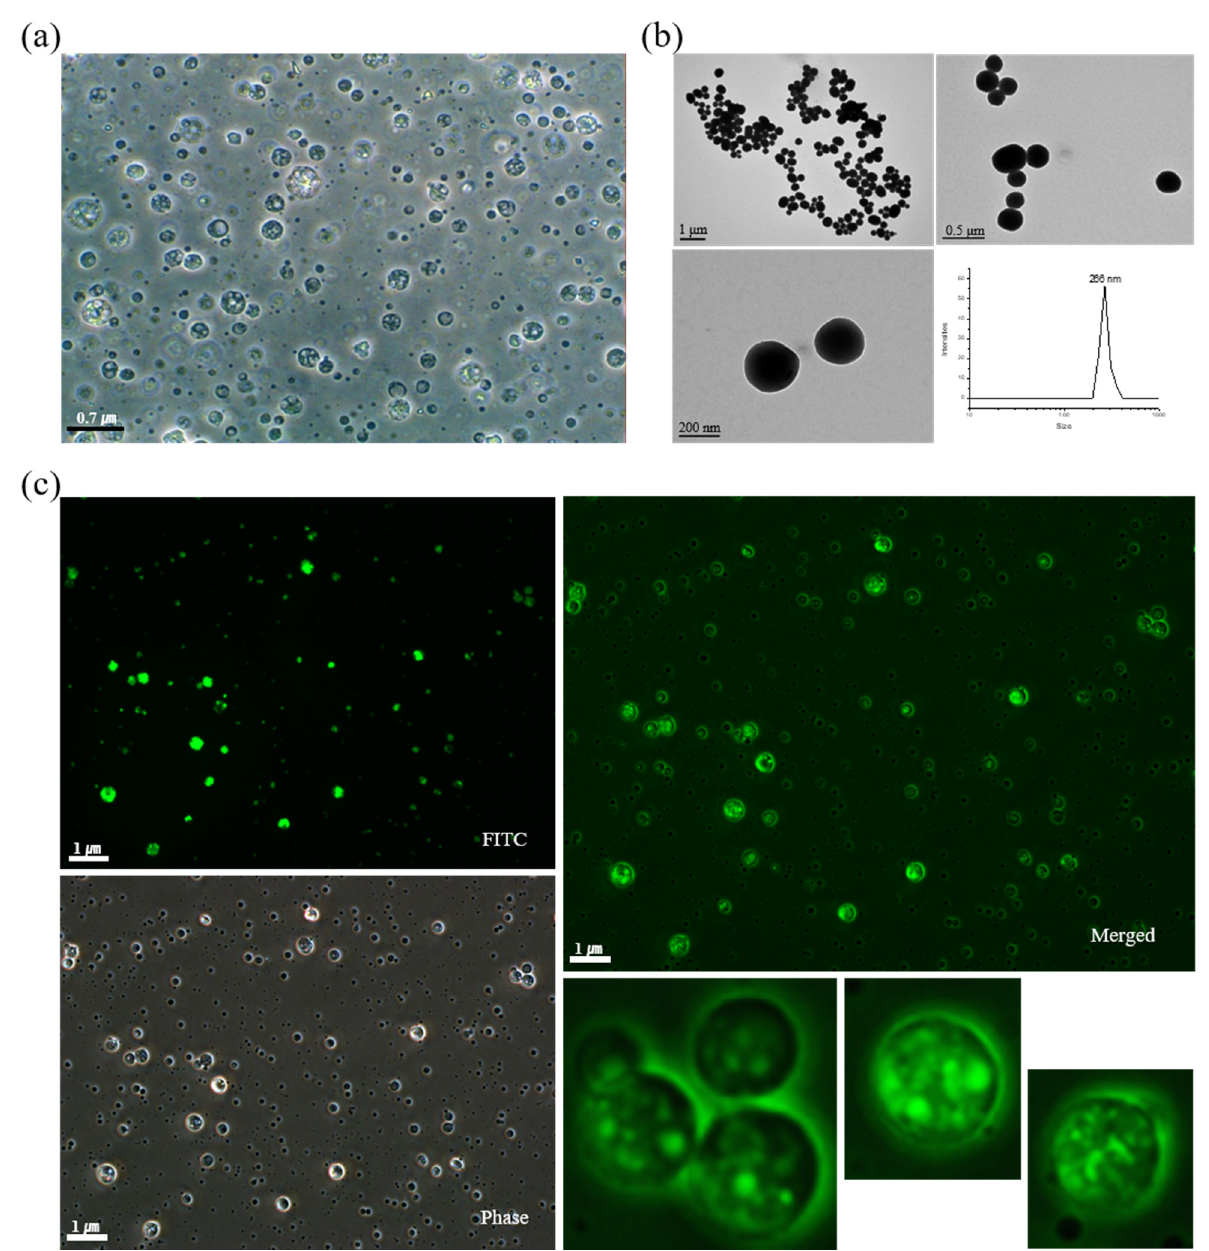
Figure 2. ( a ) Microscopy image of blank LTU nanoparticles; ( b ) TEM and DLS results of FITC-BSA LTU nanoparticles; ( c ) fluorescence microscopy images of FITC-BSA LTU nanoparticles.